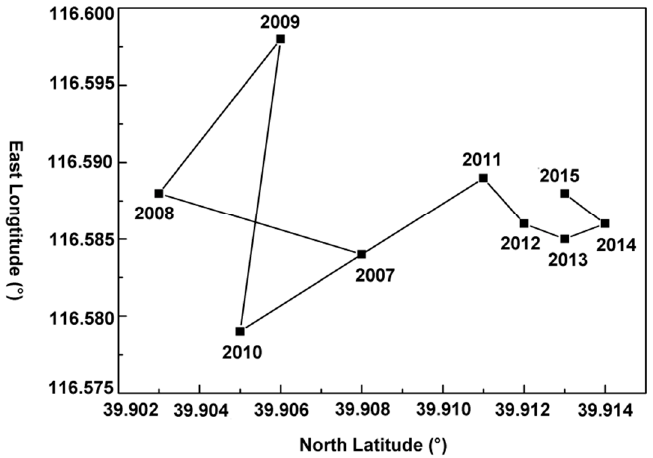
Figure 5. Changes in the SDE central migration trajectory from 2007 to 2015.